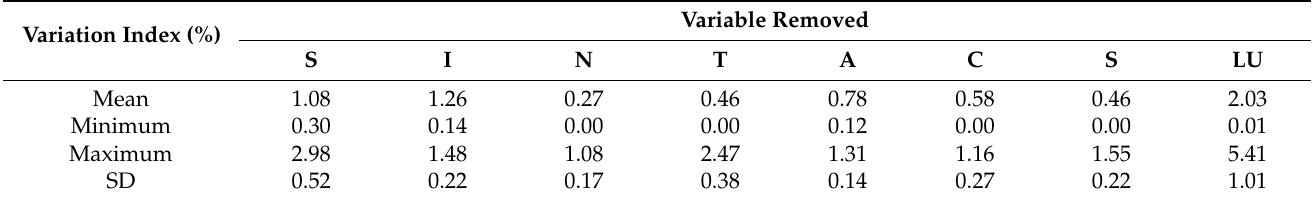
Table 4. Statistical summary of the SINTACS-LU map removal sensitivity analysis.